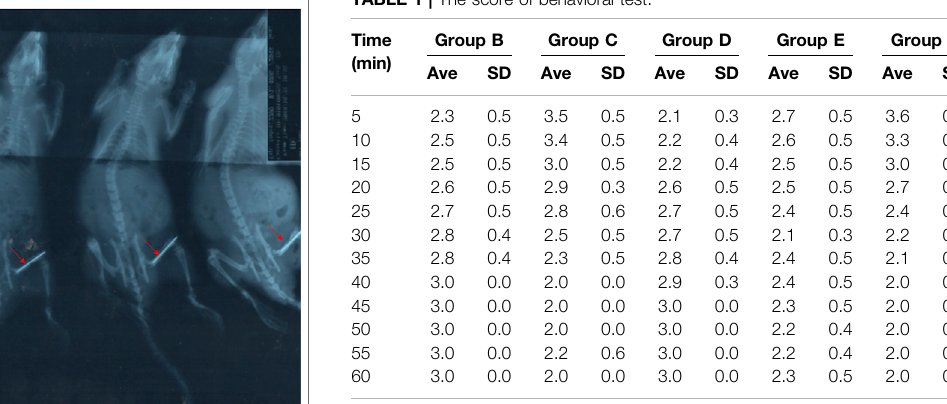
TABLE 1 | The score of behavioral